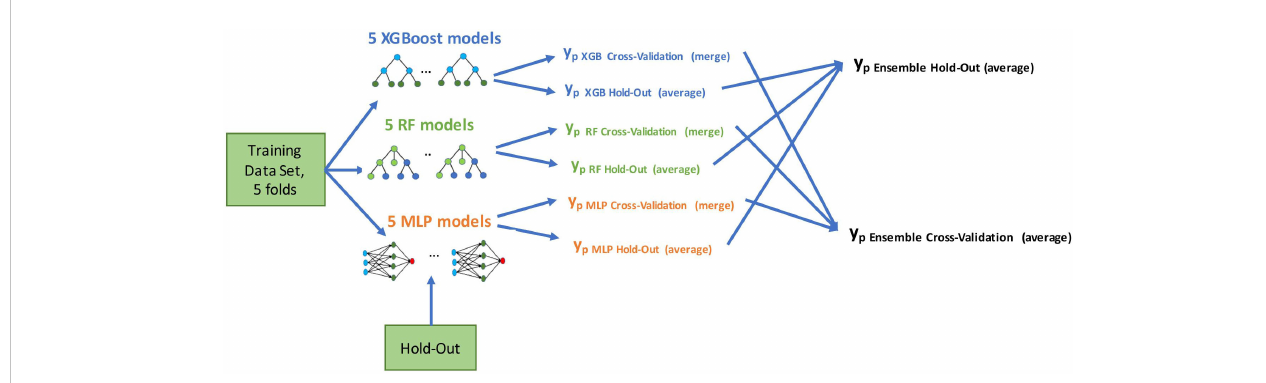
FIGURE 2 Model development fl ow. We built fi ve models using training data in a cross-validation method (four folds for training, one fold for evaluation, fi ve times in a round-robin manner). Evaluation was done on both cross-validation and hold-out predictions; y p marks a vector of predicted